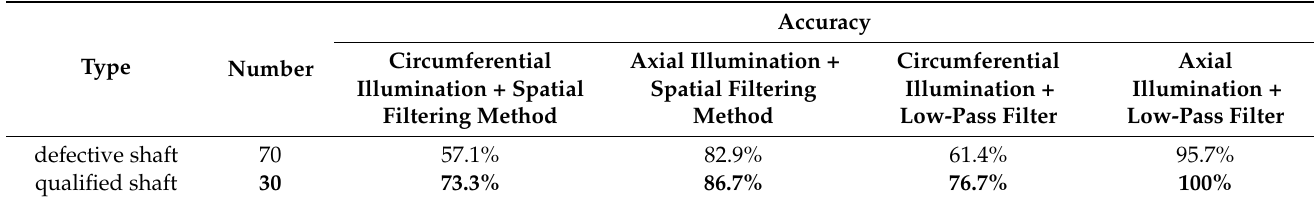
Table 1. Surface hollow defect identification